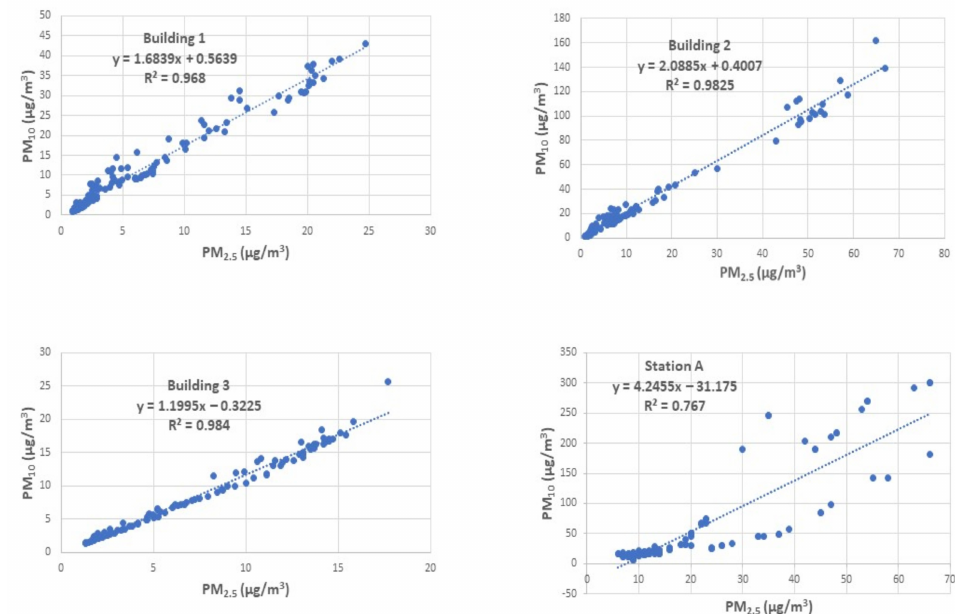
Figure 8. PM 10 plotted versus PM 2.5 for the three buildings (1, 2, and 3) and station